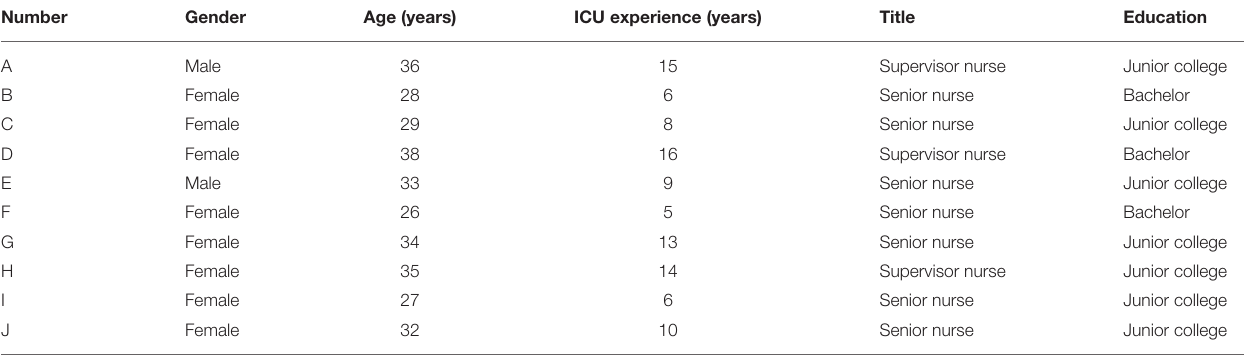
TABLE 2 | General characteristics of the interviewed nurses.